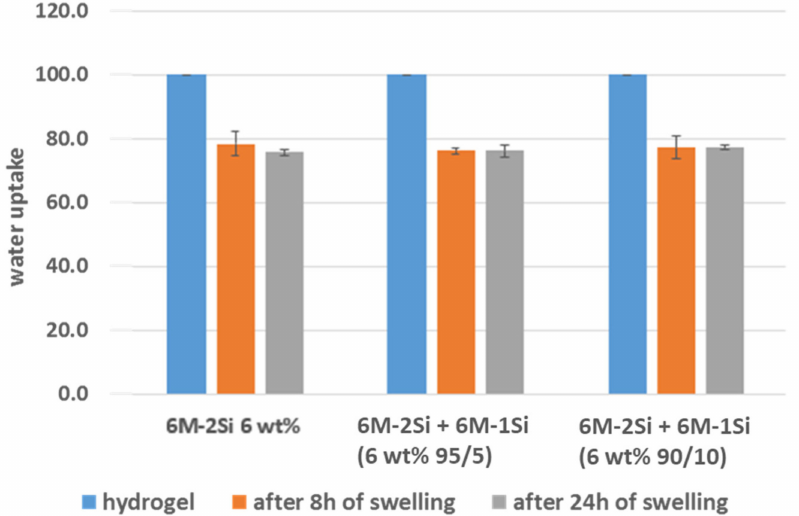
Figure 6. Water re-uptake of freeze-dried hydrogels made with 0.1 mg/mL NaF and 10 mg/mL glycine after 8 and 24 h at 37 ◦ C in DPBS pH 7.4 aged for six